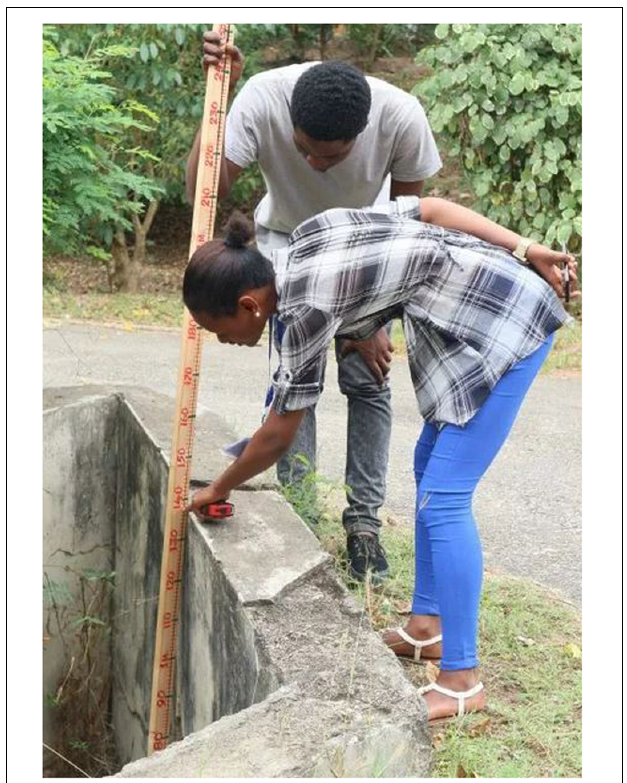
FIGURE 3 | Ramani Huria drainage mappers, recording drainage features with a wooden ruler and smartphone. Written informed consent was obtained from the participants for the publication of any potentially identifiable images or data included in this article. Photo Chris Morgan/World Bank.